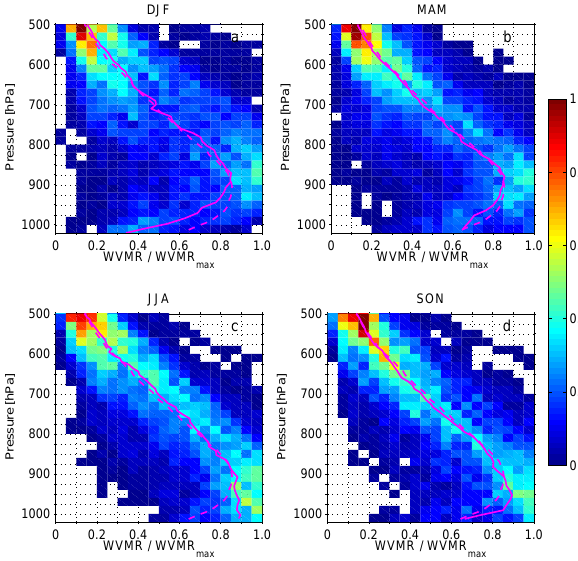
Fig. 8. SHEBA seasonal radiosounding RFDs (contours, %) of the vertical distribution (hPa) of the WV MR normalized by the profile maximum WV MR for (a) DJF, (b) MAM, (c) JJA and (d) SON. The seasonal median normalized WV MR (magenta line) and the median for all profiles (magenta dashed) are included.